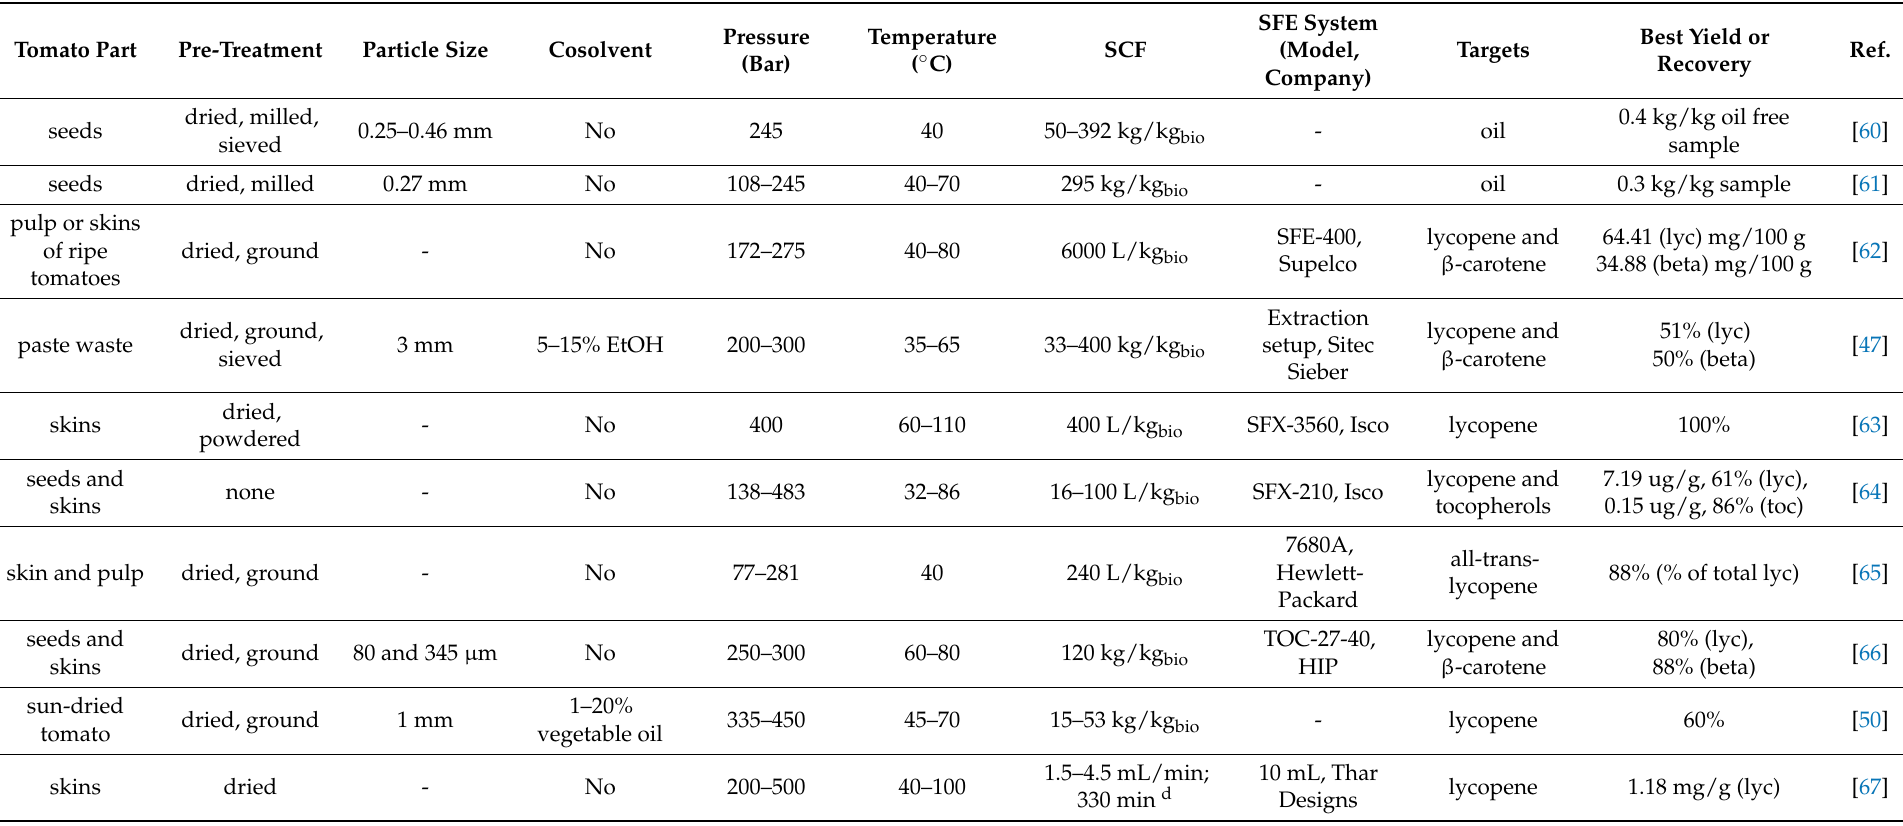
Table 1. Summarized information on scientific articles dealing with the SFE of tomato. Scopus search for articles containing the words “supercritical